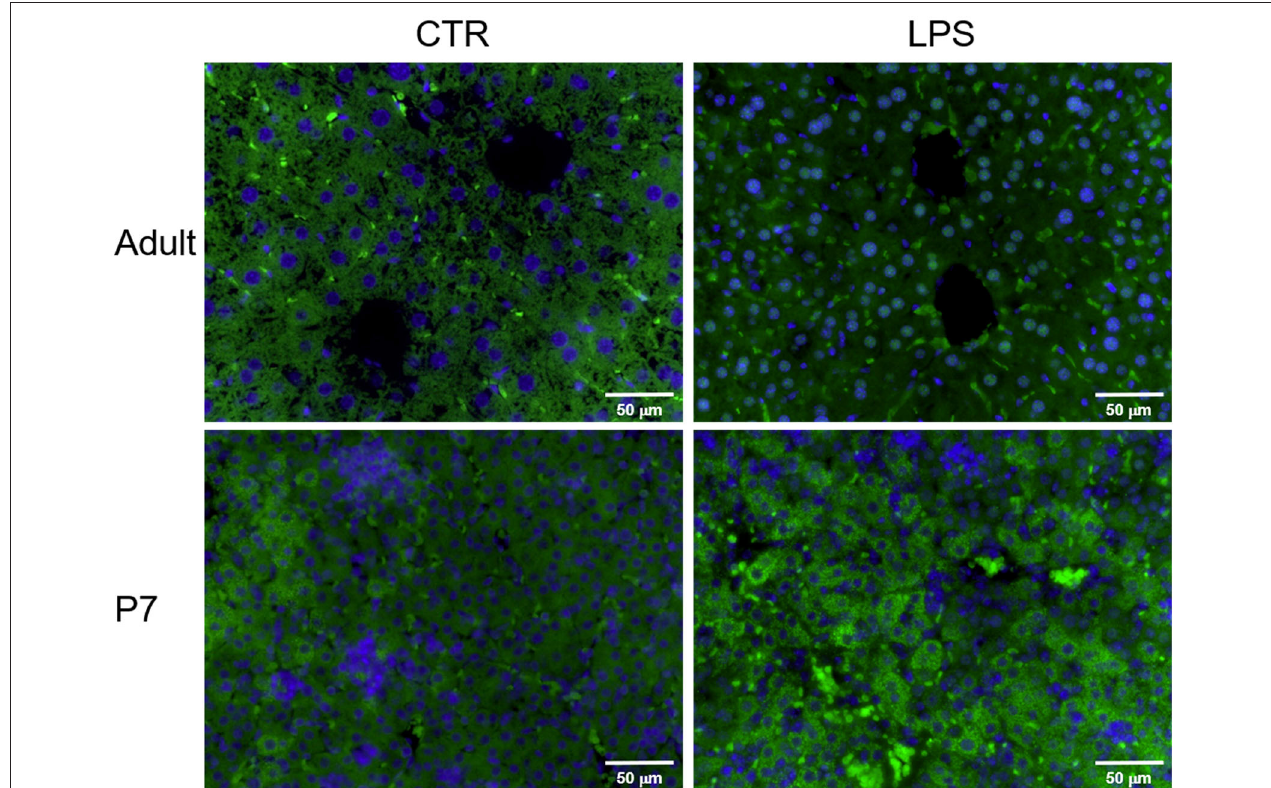
FIGURE 3 | The NF- κ B subunit p65 is translocated into the nucleus in the liver of IP LPS-exposed adult mice. Representative histological pictures of control (CTR) and LPS-exposed (5 mg/Kg, 1h) adult and p7 livers. NF κ B subunit p65 was stained in green (FITC) and cell nuclei was stained in blue (DAPI). Internal scale bar to 50 µ m. Image at